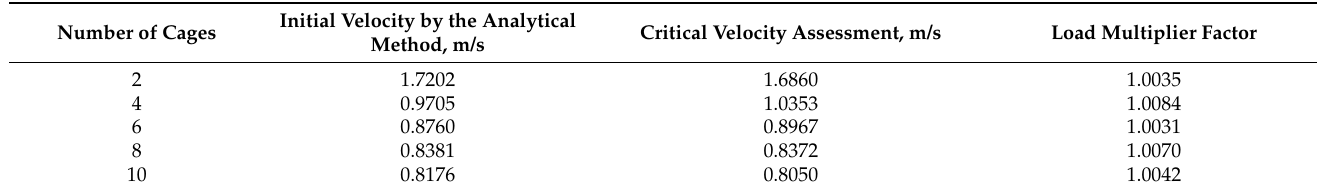
Table 5. The effect of the number of cages on the critical velocity, for the Drift State.